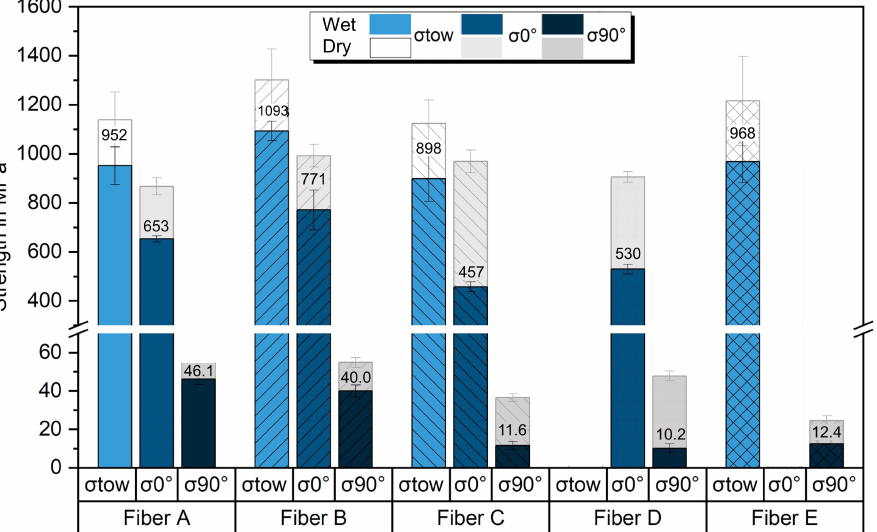
Figure 6. Quasi-static absolute fiber bundle, longitudinal and transverse tensile strength of UD GFRP composites with different NCF input after accelerated aging of the composites in 50°C water until saturation. Dry reference values are shown in grey shade for comparison. Patterns are according to the NCF